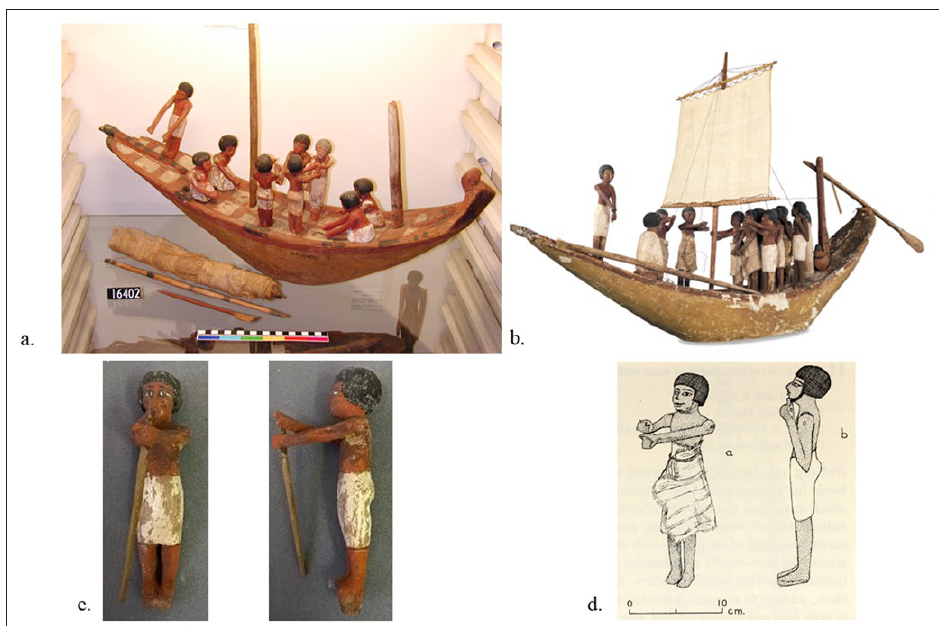
Figure 4: a) Boat UC16402 (Courtesy of the Petrie Museum of Egyptian Archaeology, UCL) of unknown provenance compared with b) a boat from Meir © British Museum EA 25360. c) Figure UC31727 (© GED) of unknown provenance compared with d) the crew members of the boat from Meir (b) (cf. Glanville 1972: